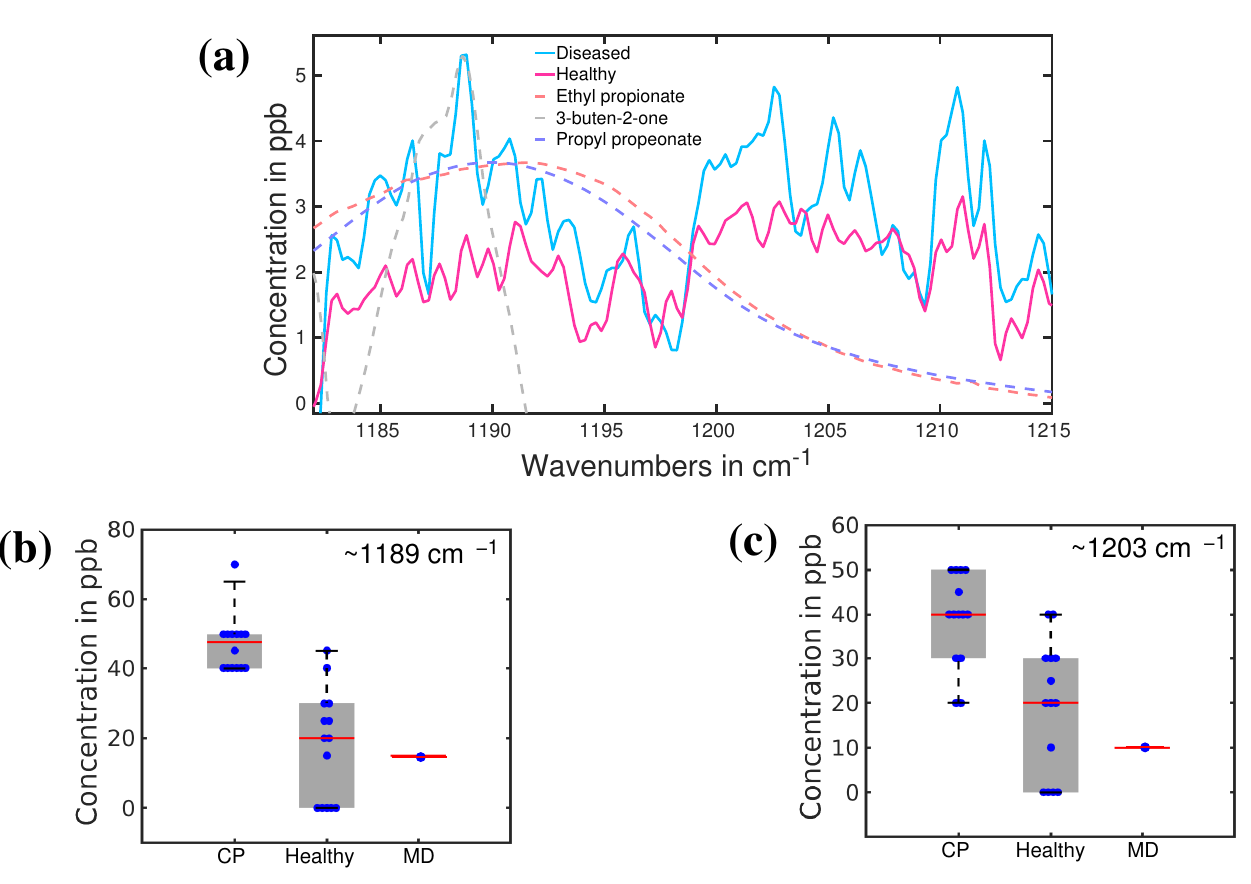
Figure 10. ( a ) The average absorption spectra of healthy (red) and CP (blue) volunteers. Dashed lines: fitting curves of three main VOC candidates; ( b , c ), plot boxes for healthy, CP, and a patient with muscular dystrophy (MD), with the corresponding median values and error bars.